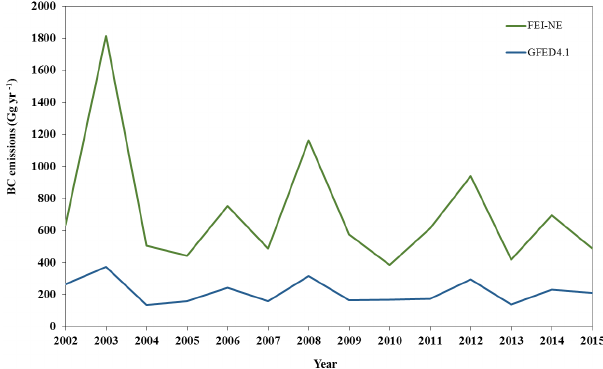
Figure 9. Comparisons of annual BC emissions from biomass burn- ing in northern Eurasia from 2002 to 2015 estimated by FEI-NE and GFED4.1.